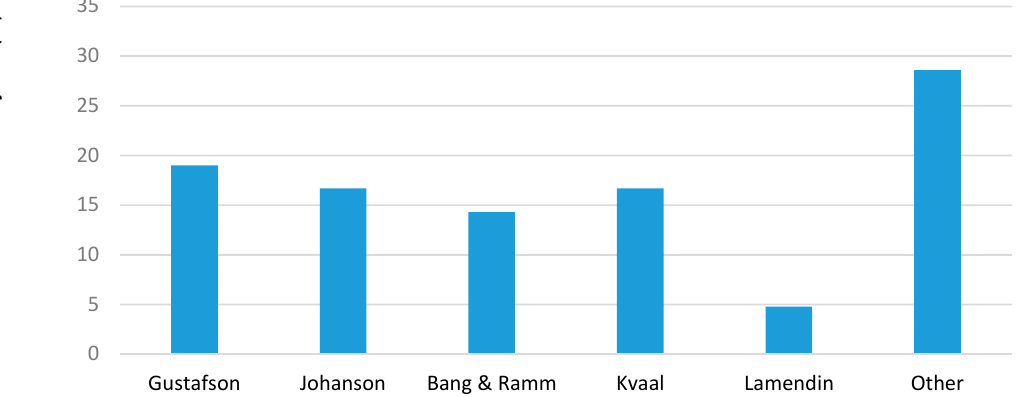
Figure 6. Types of methods used for age estimation in the deceased